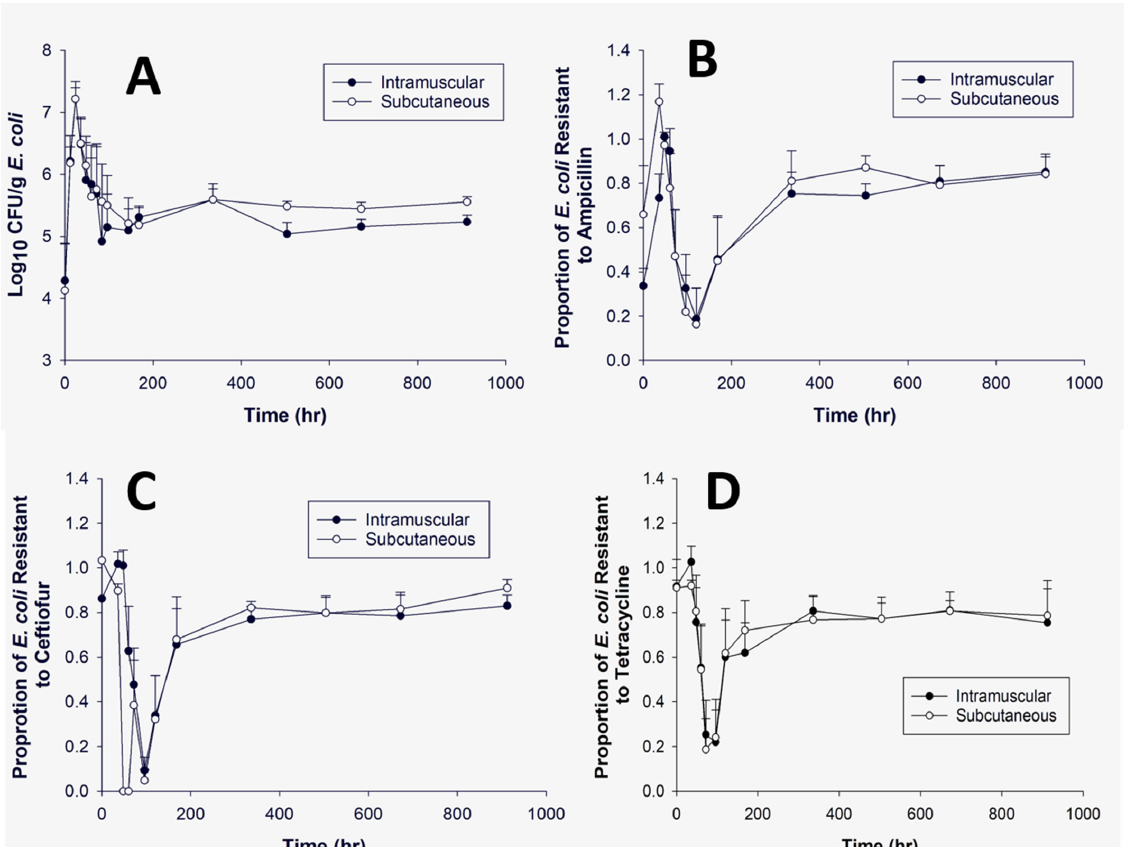
Figure 4. This panel represents E. coli isolates grown over time with no antibiotic ( A ), ampicillin (32 µg/mL) ( B ), ceftiofur (8 µg/mL) ( C ), or tetracycline (16 µg/mL) ( D ). The dark circle presents the intramuscular dosing group and the open circle represents the subcutaneous dosing group over a 912 h time period. Panel A demonstrates the log 10 CFU/g of E. coli . Panels B–D show the proportion of E. coli demonstrating phenotypic resistance based on human breakpoints. Bars represent the standard error of the mean. There were no significant differences noted for each dosing group per plain and antibiotic infused plates at the predetermined time points.